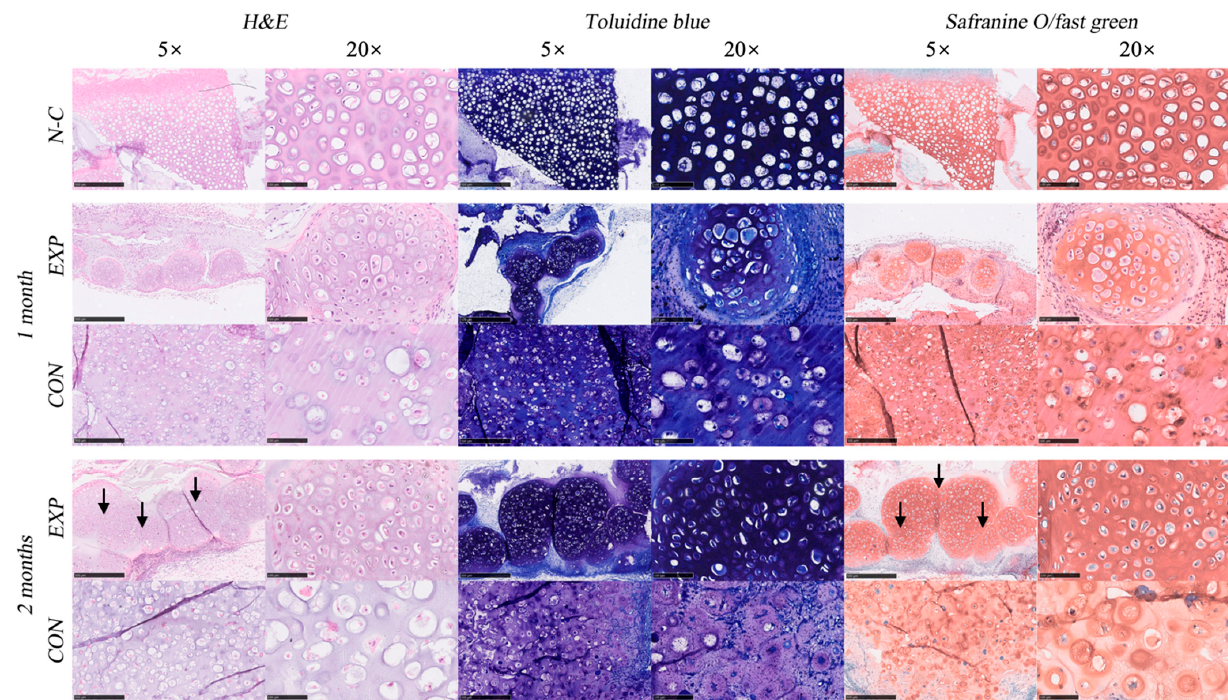
Figure 5. The H&E staining, toluidine staining, and safranin O/fast green staining of natural cartilage (N-C), the EXP group, and the CON group, after 1 month and 2 months of implantation, under the microscope with a magnification of 5 × (scale bar = 500 µ m) and 20 × (scale bar = 100 µ m). From the H&E staining and safranin O/fast green staining of the EXP group at 2 months, we can observe the fusion and merge of neighboring spheroids, as shown by the black arrows.